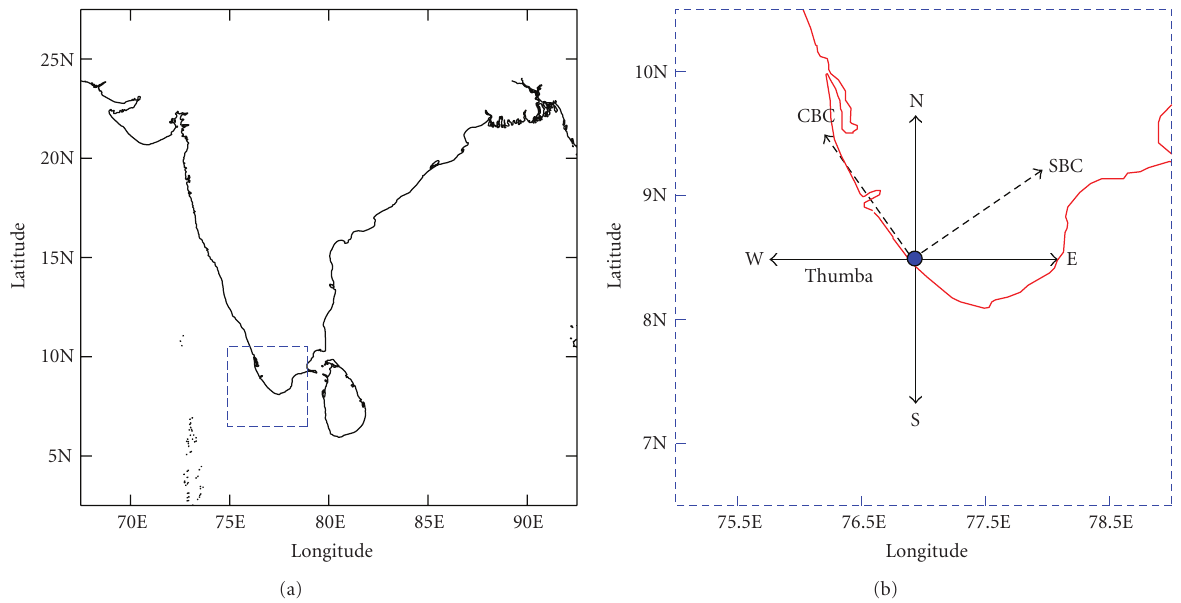
Figure 1: Location of Thumba depicting the direction of sea and coastal breeze